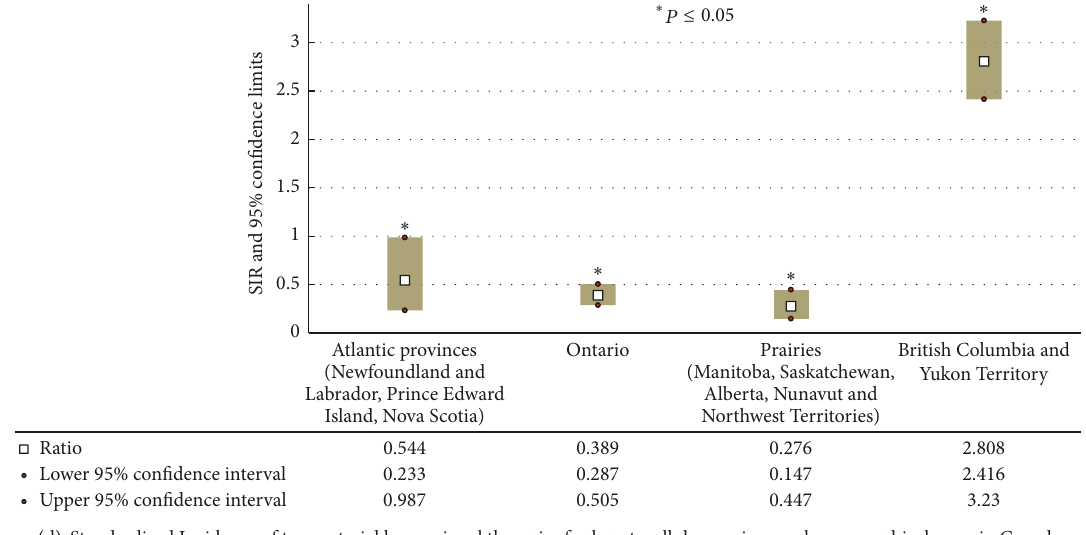
Figure 1: Standardized Incidence Ratio (SRI) and respective 95% confidence limits for ablation (a), hepatic resection (b), liver transplantation (c), and transarterial locoregional therapies (d) for the treatment of primary hepatic liver tumors in Canada during the period between 2002 and2013.ValuesofSRIequalto1.0indicatedthatthetreatmentmodalityintheregionwasequaltotheexpectedcountrywideaverageadjusted for age and gender of the population. SIR values more or less than 1.0 indicated that the treatment modality was above or below the expected countrywide average adjusted for age and gender. Statistically significant differences were identified when 95% confidence intervals of SIR did not include the value of 1.0 ( ∗ 𝑃 value ≤